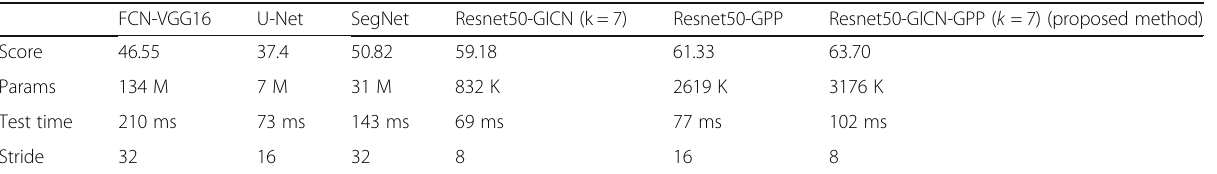
Table 1 Camelyon16 segmentation results comparison